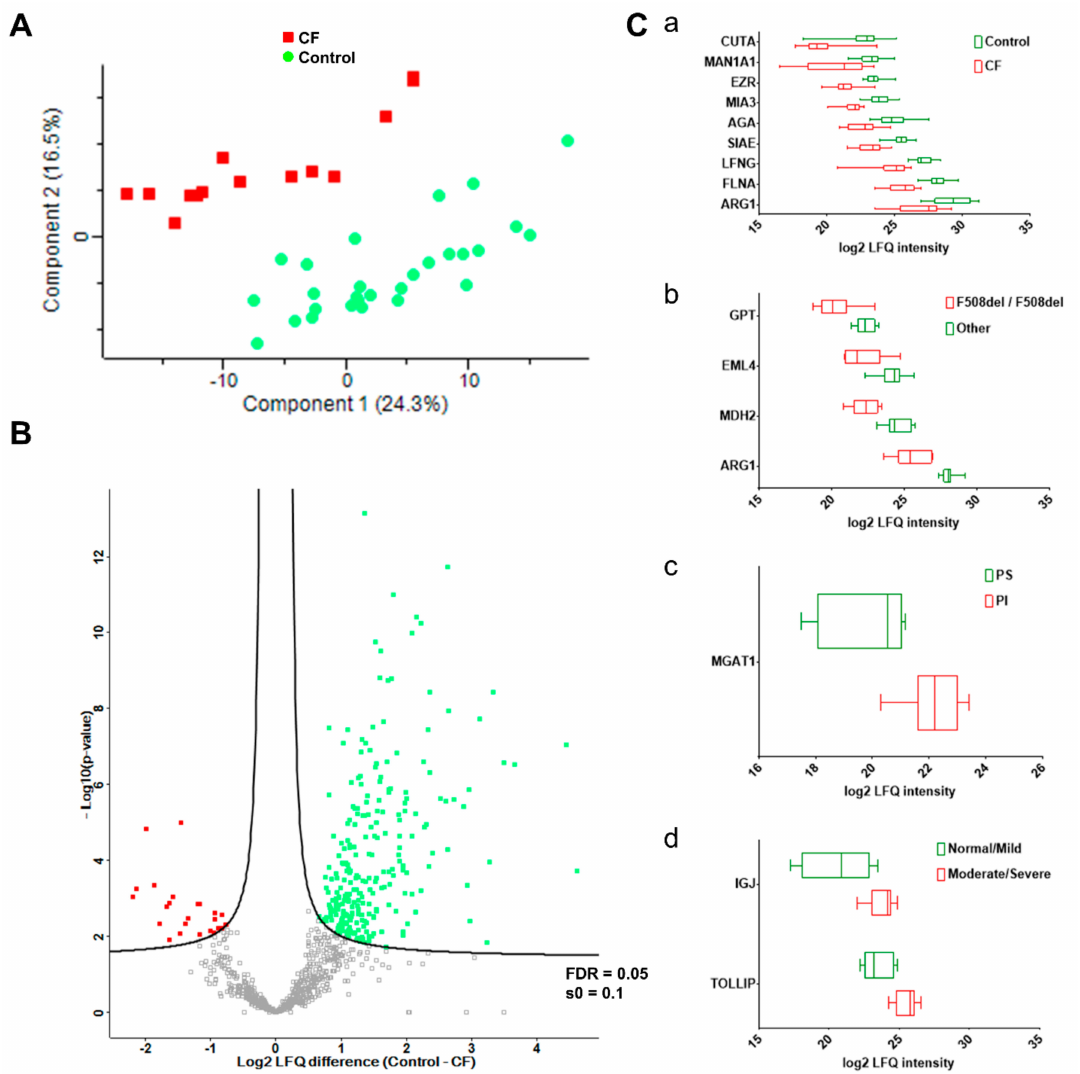
Figure 4. CF status and severity correlated with disease-specific abundances of sweat proteins. ( A ) PCA, CF (plain red squares), control (plain green dots). ( B ) Volcano plot, CF-overexpressed (plain red squares), CF-underexpressed (plain green squares), threshold curve (black bold line, FDR = 0.05, s0 = 0.1). ( C ) Box-and-whiskers representation of sweat protein abundances for ( a ) CF, ( b ) F508del homozygous, ( c ) PI, and ( d ) lung function candidate